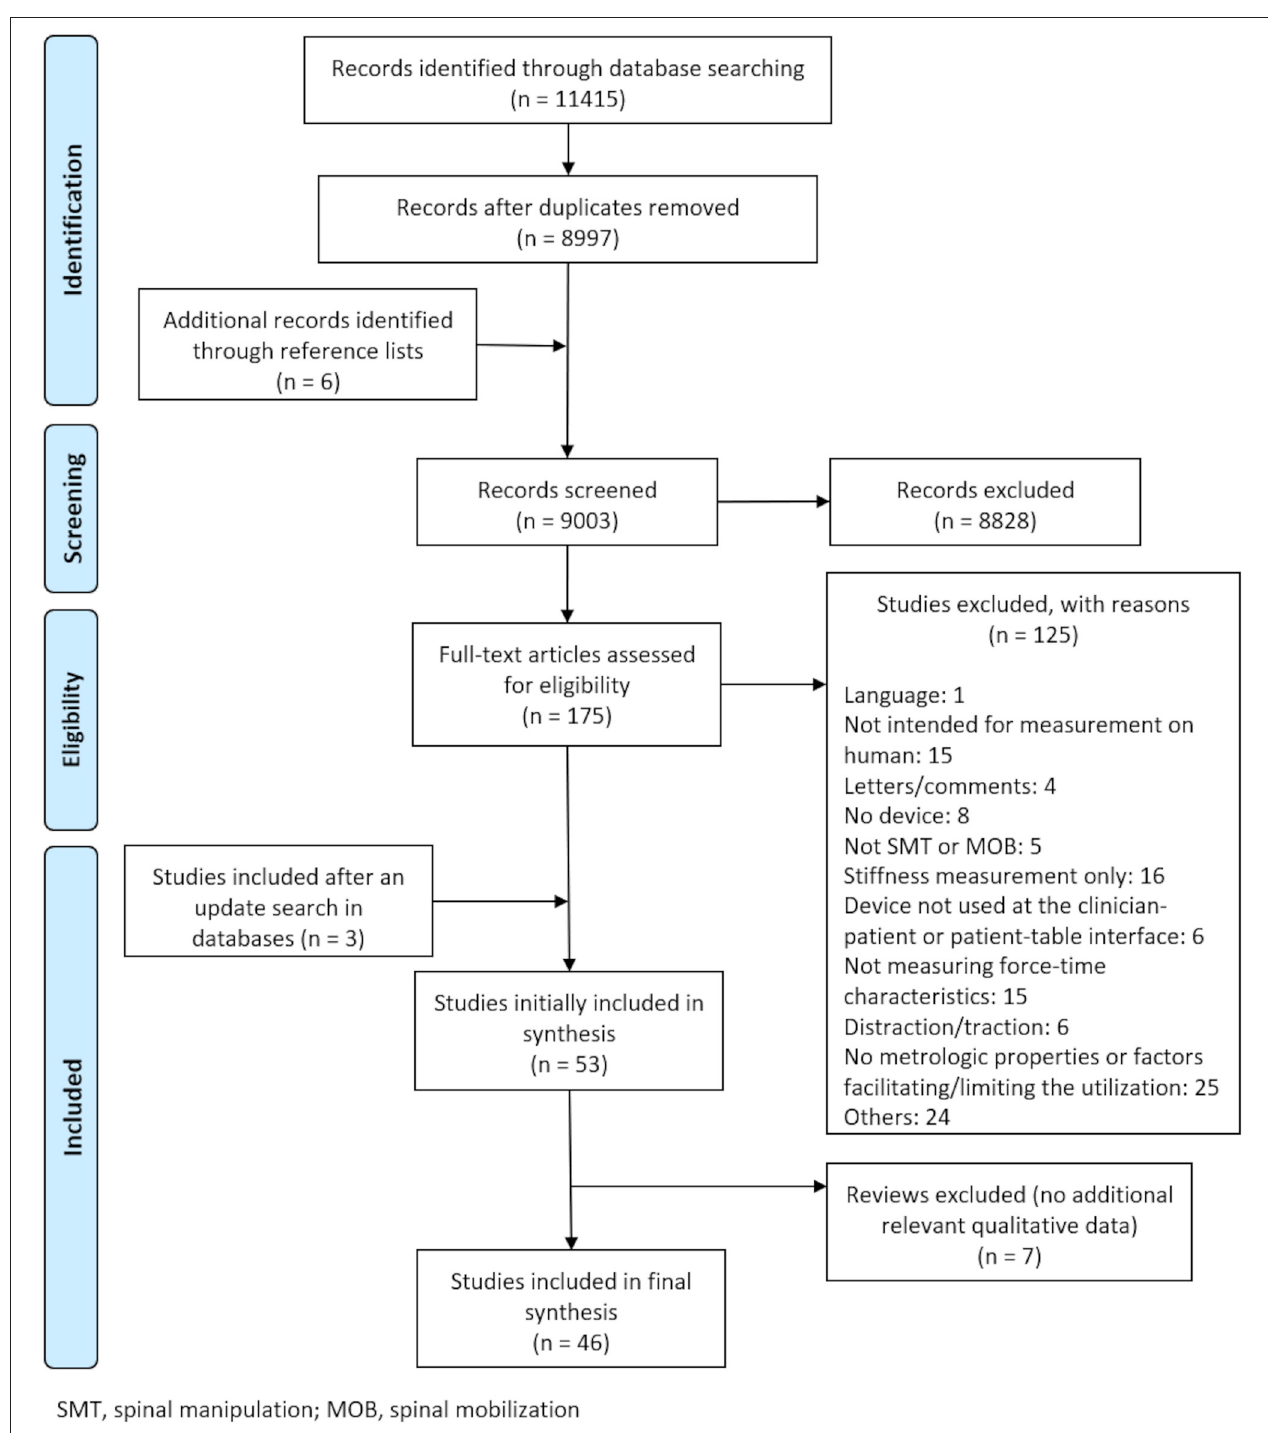
FIGURE 1 | PRISMA diagram.